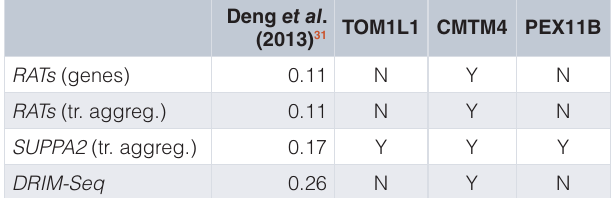
Table 1. comparison of the results by Deng et al. (2013, 31) against the results of RATs , SUPPA2 and DRIM-Seq , using the same data and annotation (Ensembl v60). The first column shows the fraction of the 248 genes that was recaptured by each method. For methods reporting at the transcript level, results were aggregated to the respective genes. The last three columns show whether the verdicts for each of the validated genes (DTU Yes/No). DTU: Differential transcript usage.